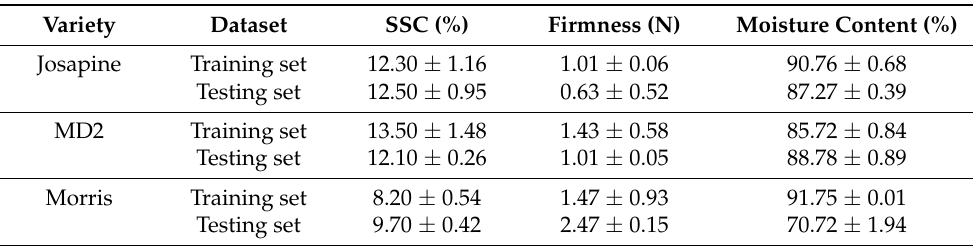
Table 2. Physicochemical properties measured in the training and testing sets from three pineap- ple